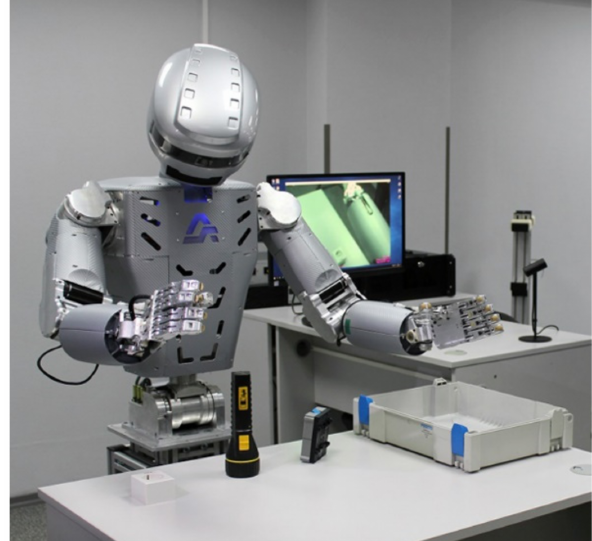
Figure 1. Robot SAR-401.